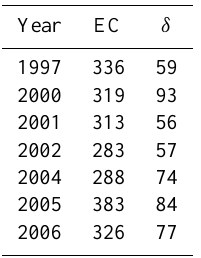
Table 6. Random error estimates ( δ) for evapotranspiration mea- sured by eddy covariance (EC), all expressed as mm a − 1